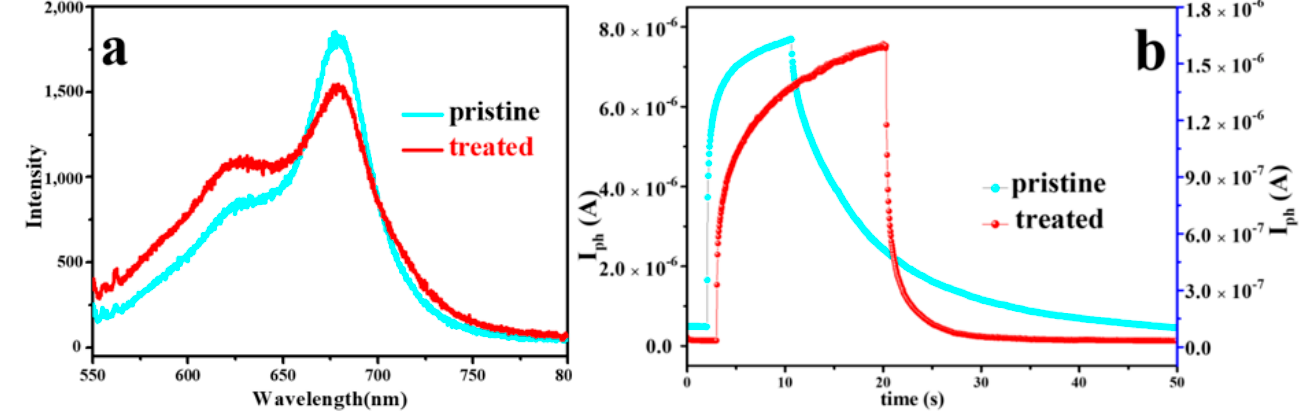
Figure 4. Evolution of PL spectra ( a ) and transient response ( b ) of MoS 2 before and after treatment under mild oxygen plasma conditions of 10 W, 50 Pa, 10 s.